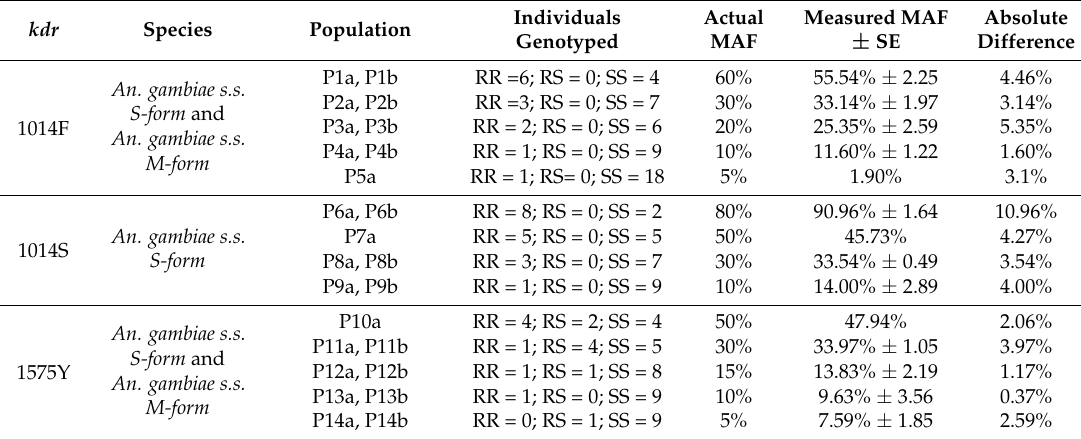
Table 3. Validation of the developed regression models: Differences in actual versus measured allelic frequencies. For populations where N= 2 replicates were analysed, the mean value ± SE of % allelic frequency is